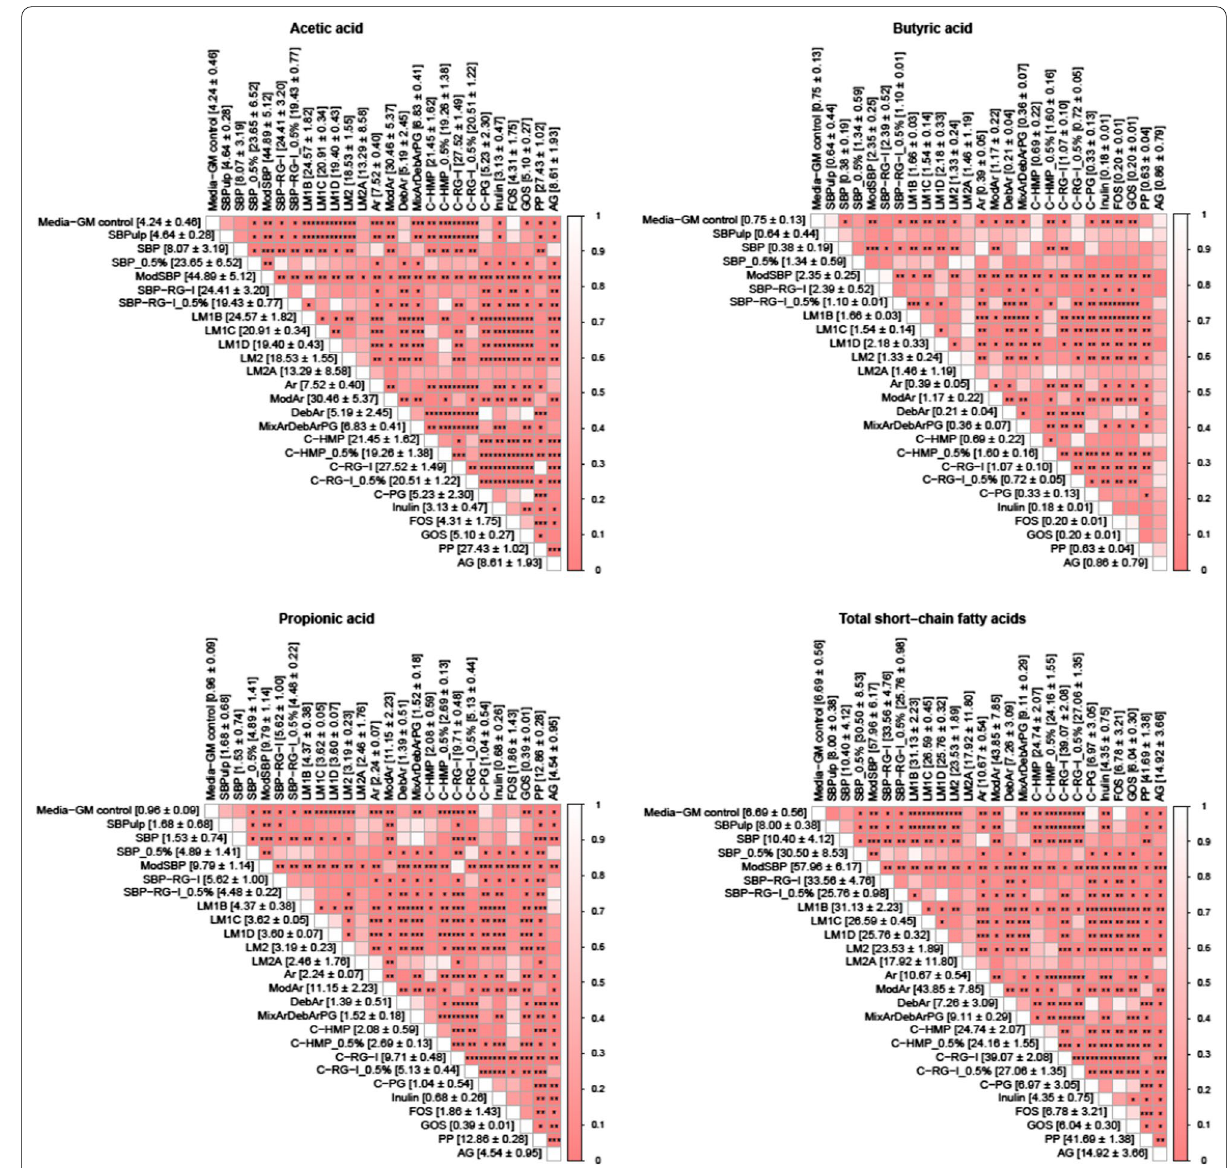
Fig. 5 Pairwise comparison of the amount of the short chain fatty acid (SCFA) produced from different substrates as determined by t -test with FDR correction. The comparisons are carried out for acetic acid, propionic acid, butyric acid as well as total SCFA. All fermentations were carried out in quadruplicate (with exceptions as stated in Fig. 1). The symbols *, **, ***represent adjusted P < 0.05, 0.01 and 0.001, respectively. The colour depth of each cell represents the adjusted P value. The values in the square brackets indicate the mean and standard deviation of the individual SCFA. Substrate codes as in Table 1. MixArDebArPG indicate mixed fermentation 1:1:1 (each 0.33% w/v) of arabinan, debranched arabinan, and polygalacturonic